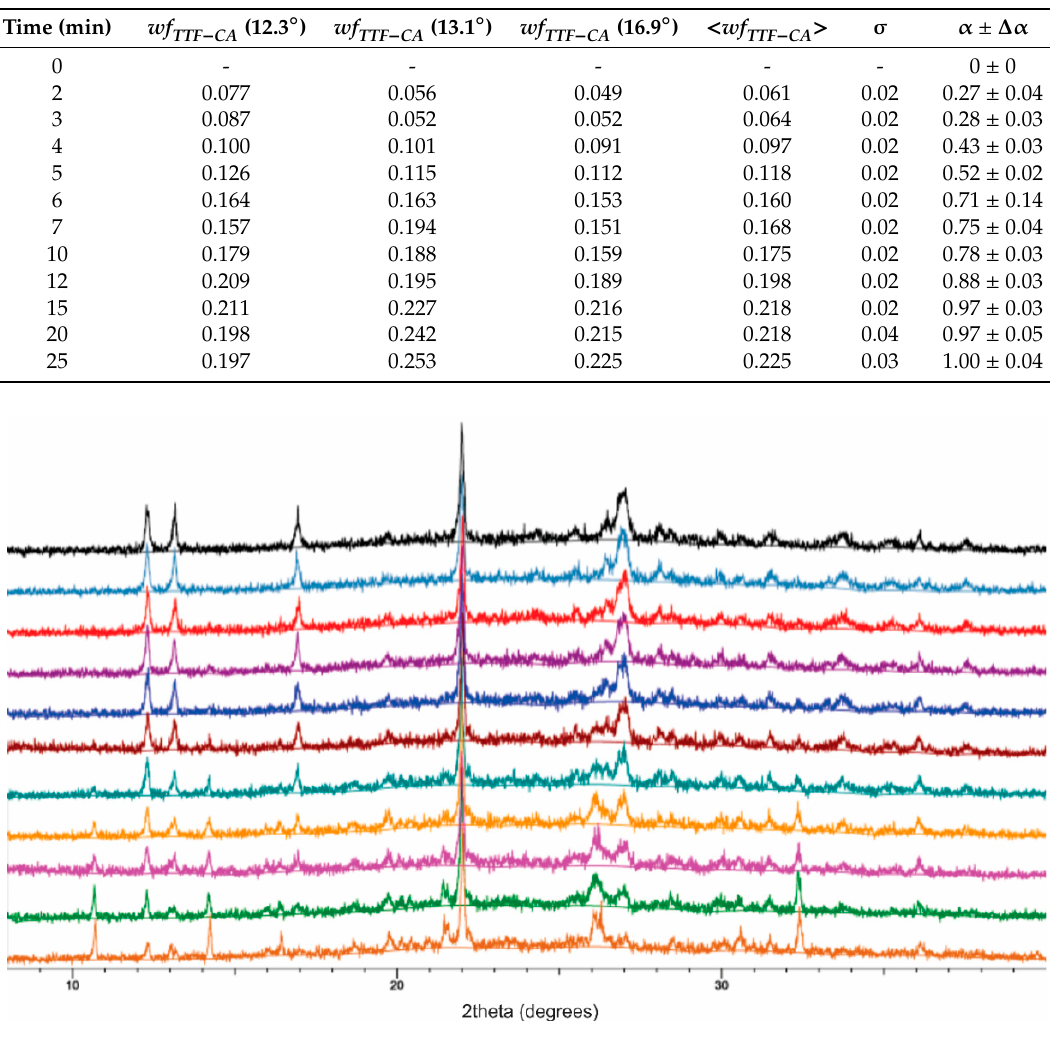
Figure 4. From bottom to top: One of the three XRPD scans of the mechanochemical products collected immediately after the LAG reaction of TTF and CA (using diethyl ether, 1 µ L / mg), for 2 min (light brown), 3 min (green), 4 min (magenta), 5 min (orange), 6 min (teal), 7 min (burgundy), 10 min (blue), 12 min (violet), 15 min (red), 20 min (light blue) and 25 min (black). After the calculation of intensity ratios from the scans, the calibration curves in Figure S2 were used for the calculation of the weight fraction of TTF-CA (green polymorph) in each reaction mixture, and the conversion fraction α reported in Table 2. The isothermal kinetic profiles for the neat and LAG reaction are graphically represented in Figure